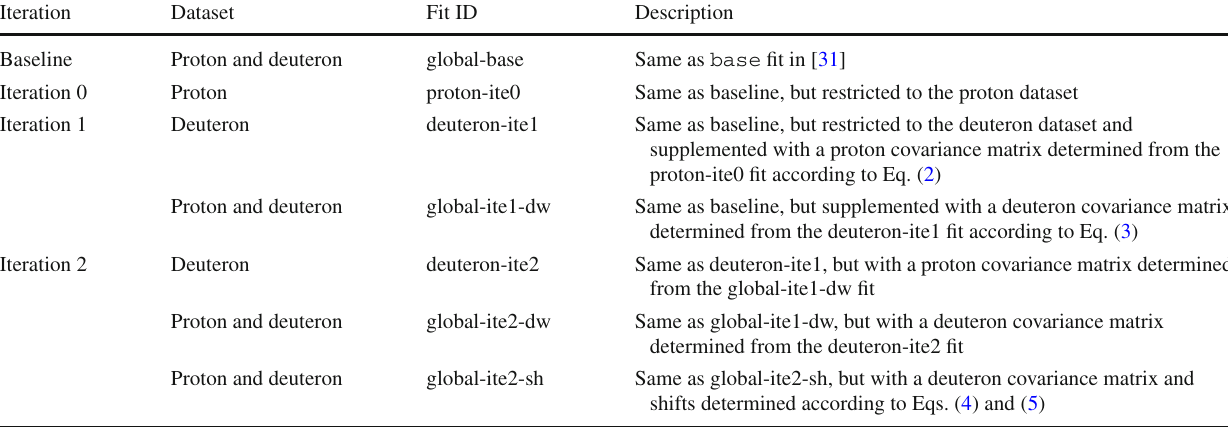
Table 1 A summary of the fits performed in this study, see text for